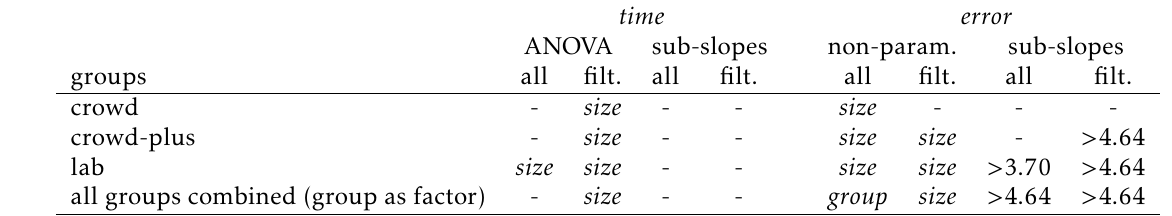
Table 1. Overview of test results from ANOVA, non-parametric tests, and the subset slopes analyses for time and error for both the overall (all) and above median filtered (filt.) dataset. Dashes (-) denote no effects; Sub-slopes entries denote IDs that as part of a subset had significantly higher slopes than the the overall slope. See the results section of the lab participants as an